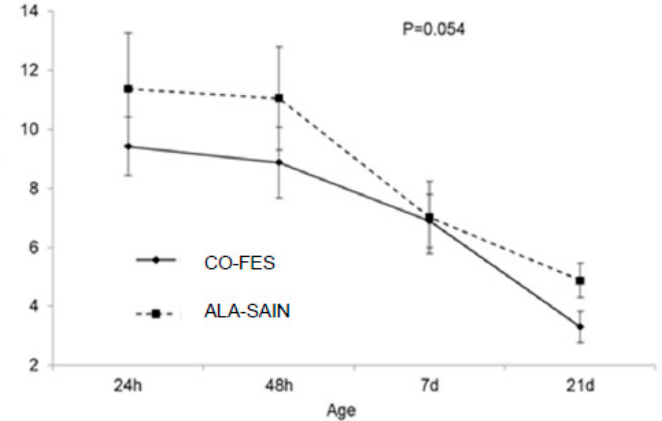
Figure 1. Changes in lamb plasma IgG concentration until 21 d of age according to pre-natal diet.